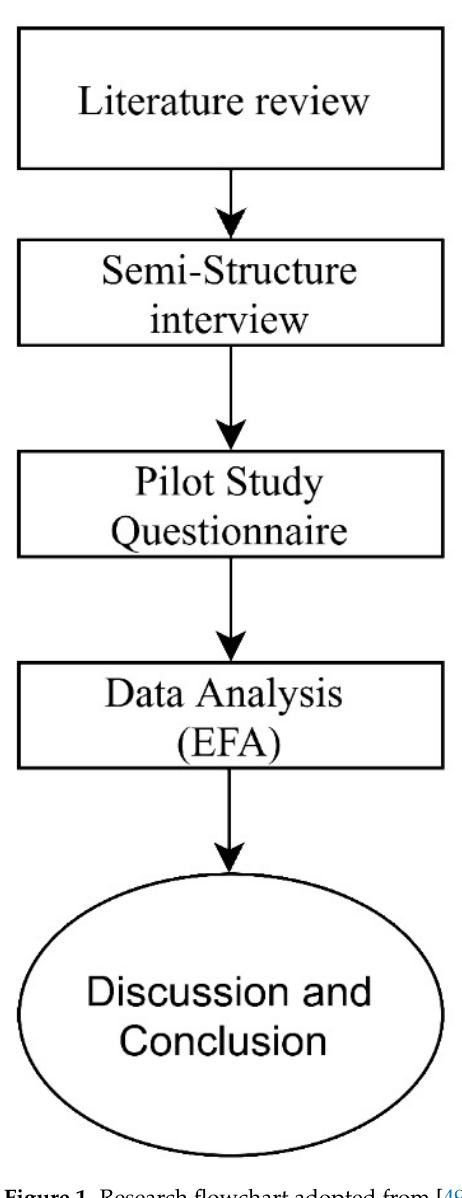
Figure 1. Research flowchart adopted from [49].